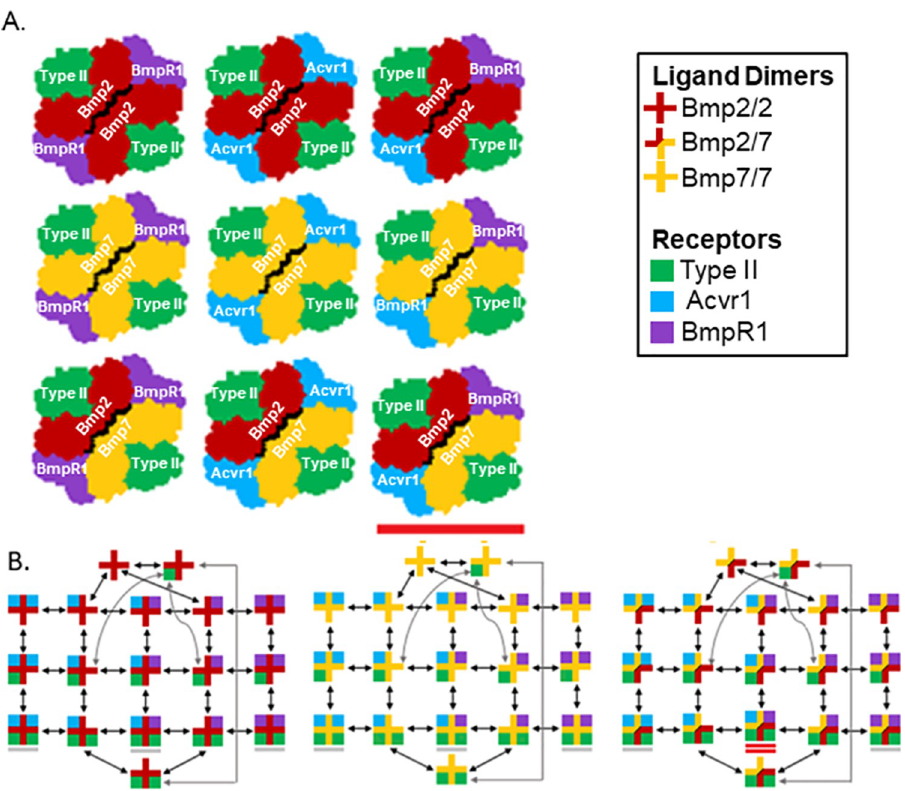
Fig 1. BMP ligand receptor interactions and oligomerization network. A. Cartoon depiction of ‘overhead view’ of BMP ligand-dimer receptor-tetramer complexes. BMP signaling occurs through an oligomeric signaling complex which necessarily consists of a ligand dimer (red/gold plus) bound to a receptor tetramer. The receptor tetramer requires two Type II receptors (green square) and two Type I receptors (BmpR1 in purple and/or Acvr1 in cyan). The heterodimer-heterotetramer is underlined in red. B. Network of BMP ligand-receptor interactions. Oligomeric signaling complexes are formed through reversible reactions (double-sided arrows). Tetrameric complexes are underlined in the figure above. The heterodimer-heterotetramer, Bmp2/7-Acvr1-BmpR1-(Type II) 2 is double underlined.